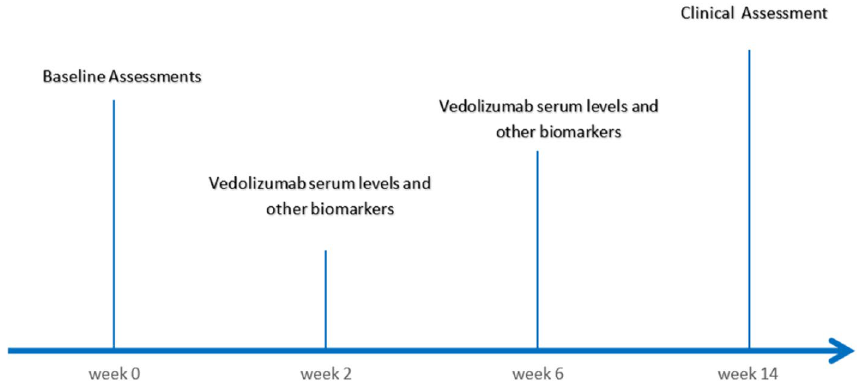
Figure 1. Patient characteristics and blood sample collection scheme.